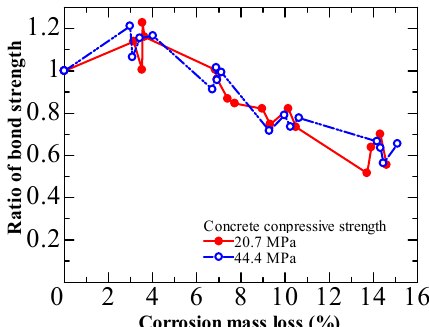
Figure 13. Influence of concrete strength on bond deterioration from Yalciner et al. [40]: ( a ) cover = 15 mm; ( b ) cover = 30 mm; ( c ) cover = 45 mm.